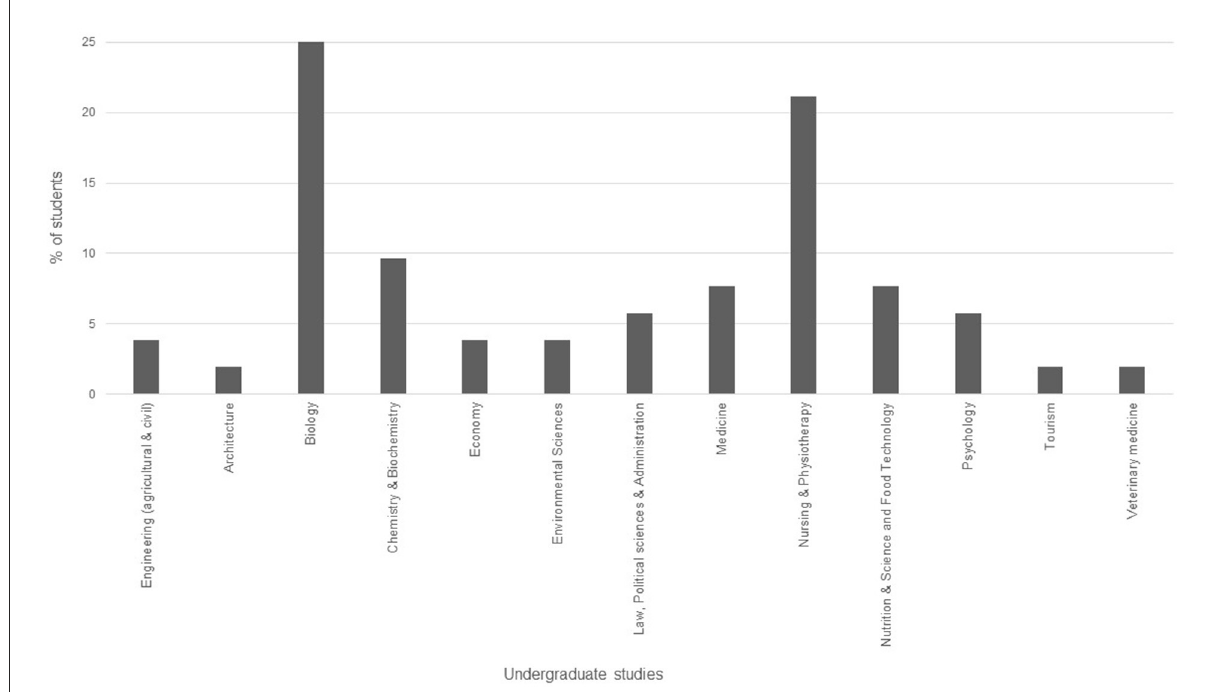
FIGURE1 Description of the academic backgrounds of the first cohort of the MSc in Planetary Health ( n = 55).